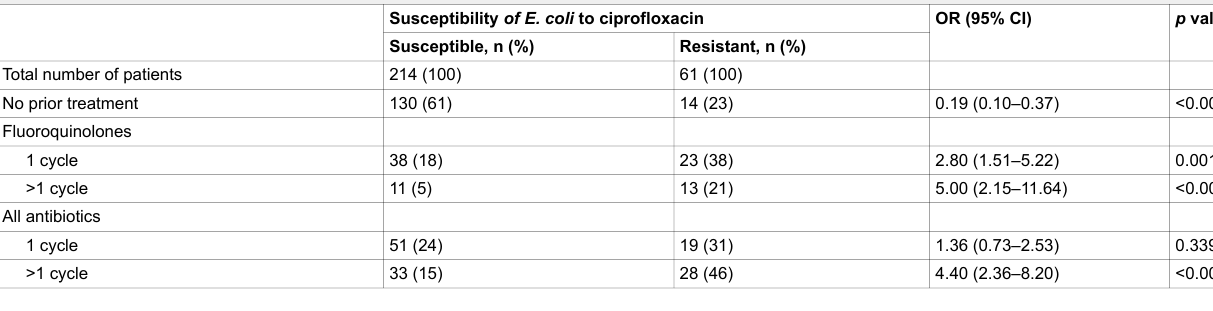
Table 4 Cumulative antibiograms of 345 E. coli isolates from 275